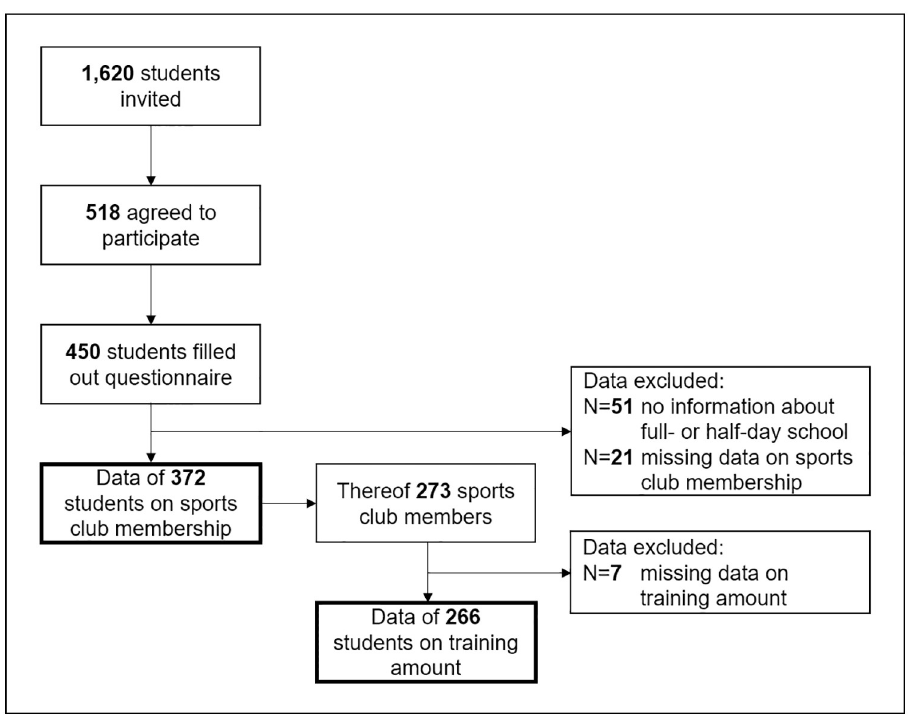
Fig 1. Flow chart of the sample selection process. Bold frames indicate final sample sizes for the statistical analyses.